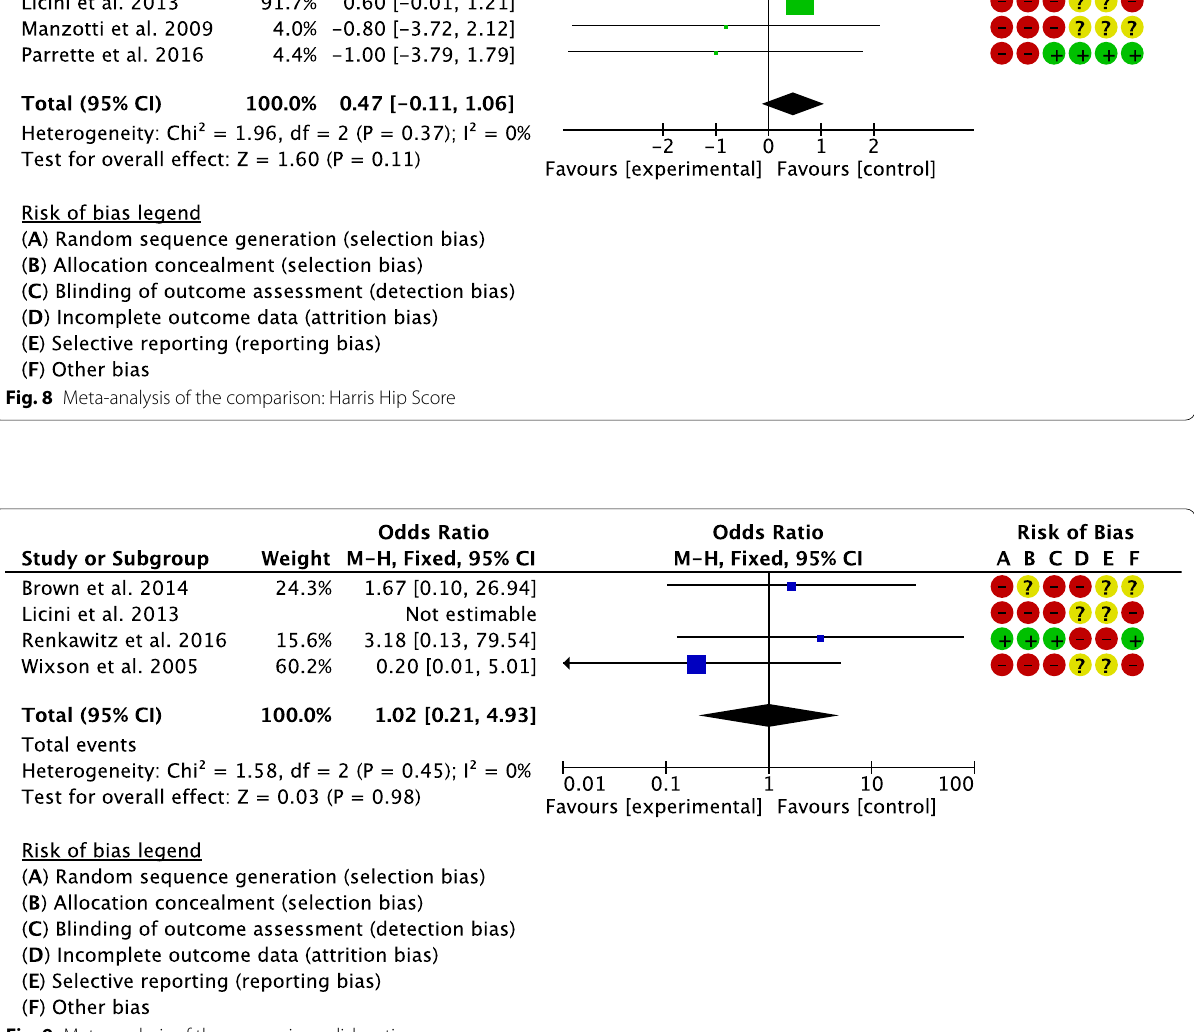
Fig. 9 Meta-analysis of the comparison: